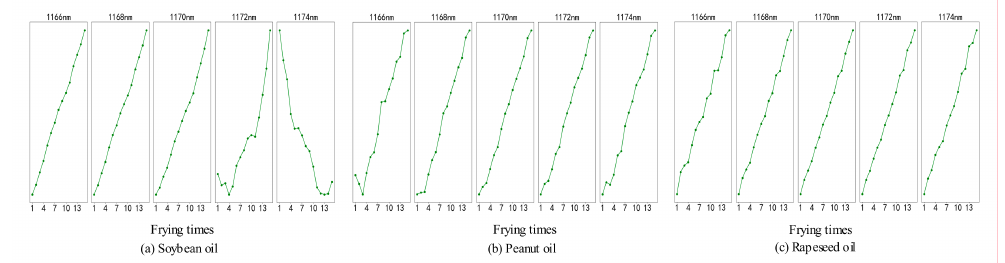
Figure 5. The relation between the Seg384 band with frying times of three kinds of oils.